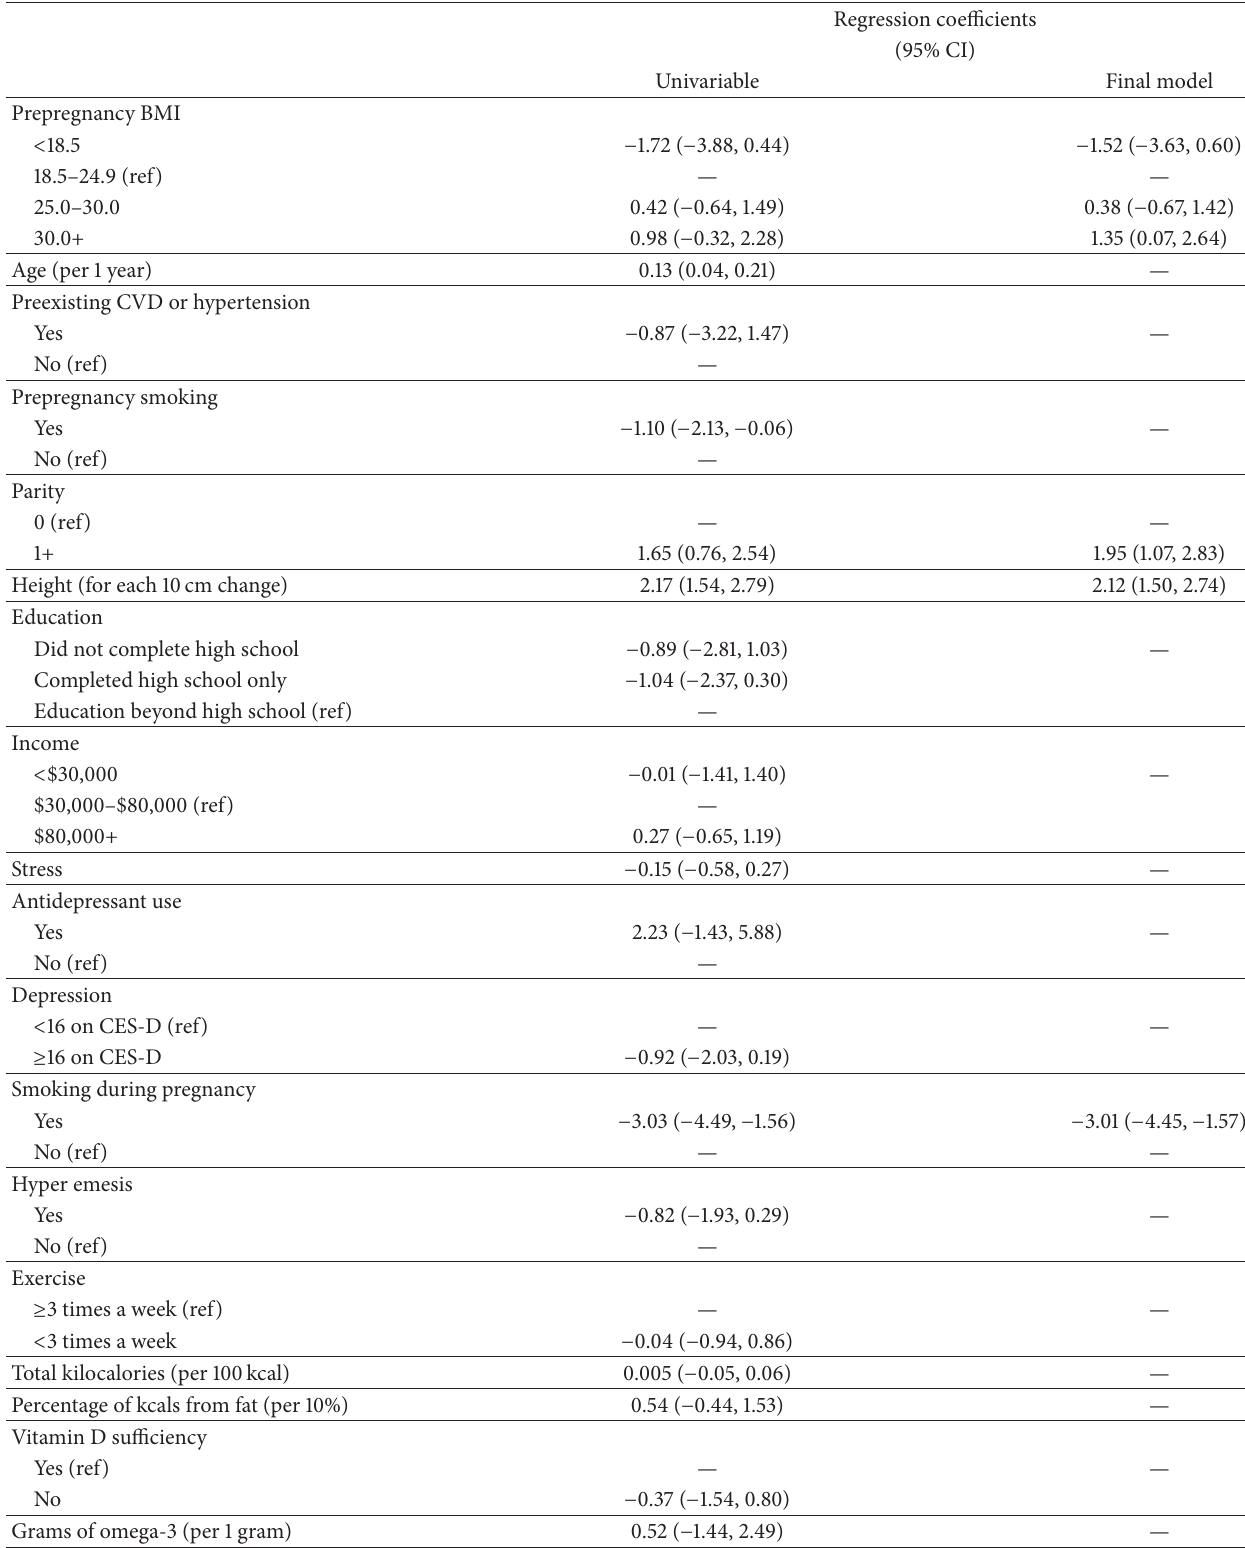
Table 3: Determinants of fetal adiposity using weight/length ratio (linear